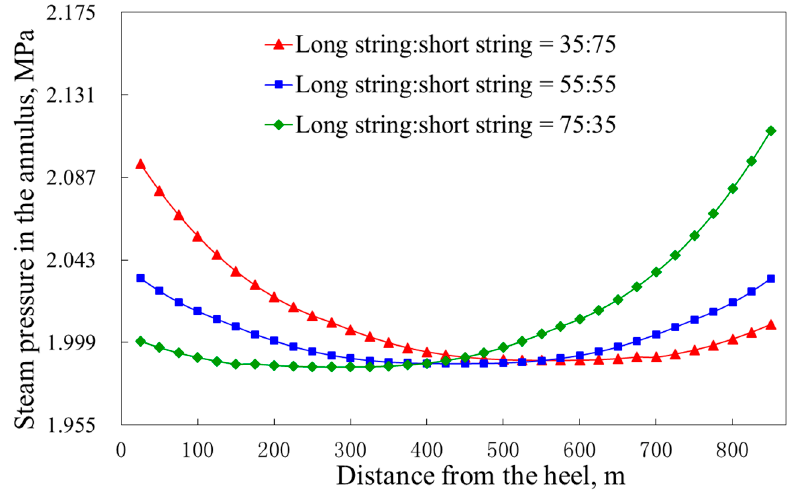
Figure 12. Effect of the steam injection ratio on the annulus pressure profiles of the injector. Figure 12. E ff ect of the steam injection ratio on the annulus pressure profiles of the